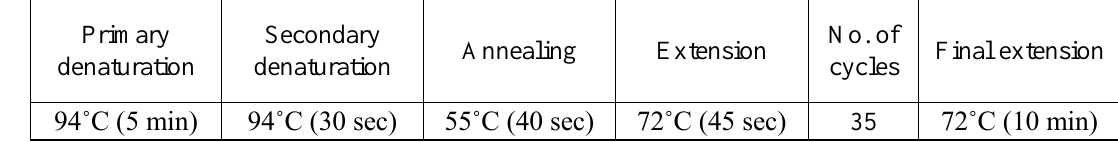
Table 2: PCR thermocycler conditions